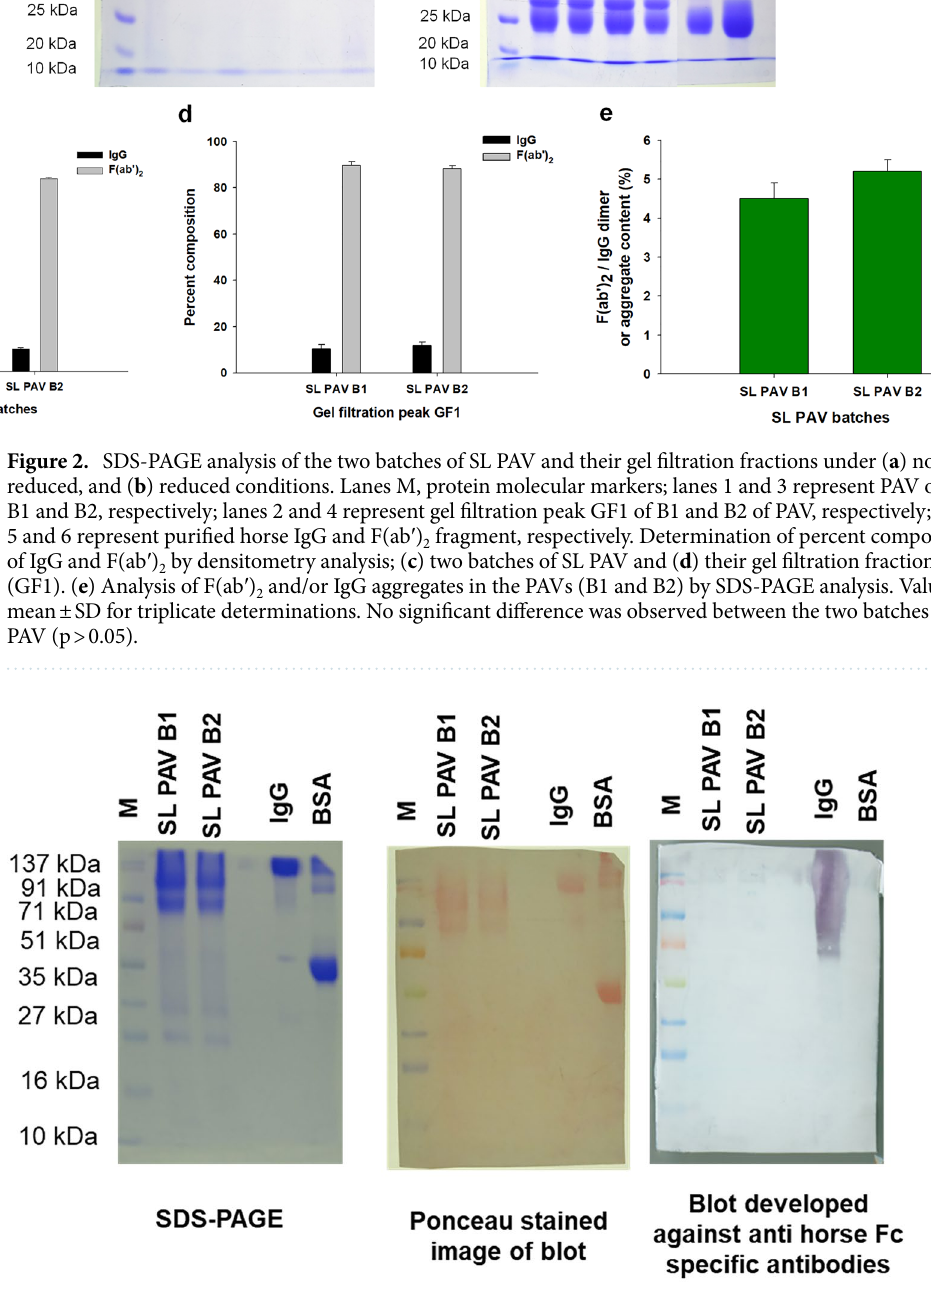
Figure 3. Determination of Fc content of IgG by Western blot analysis. Immunoblot analysis of the SL PAV B1, B2 and purified horse IgG was done by using anti horse IgG HRP conjugated Fc region-specific antibody. M represents protein molecular mass marker and B1 and B2 represent batch1 and batch 2 of PAV, respectively. The primary antibody for both the analyses was raised against Fc region of